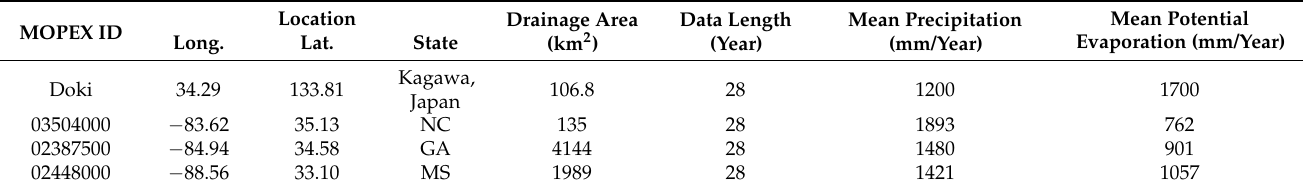
Table 1. Studied basins, locations, and basic characteristics.